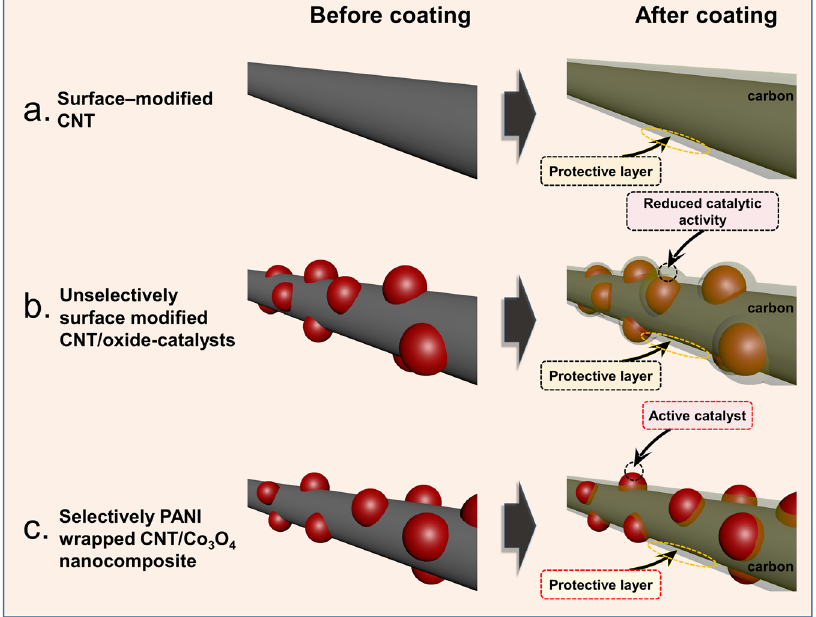
Figure 1. Schematic diagram showing ( a ) the surface-modified CNT, ( b ) the unselectively surface-modified CNT/oxide-catalysts, and ( c ) the selectively PANI-coated CNT/Co 3 O 4